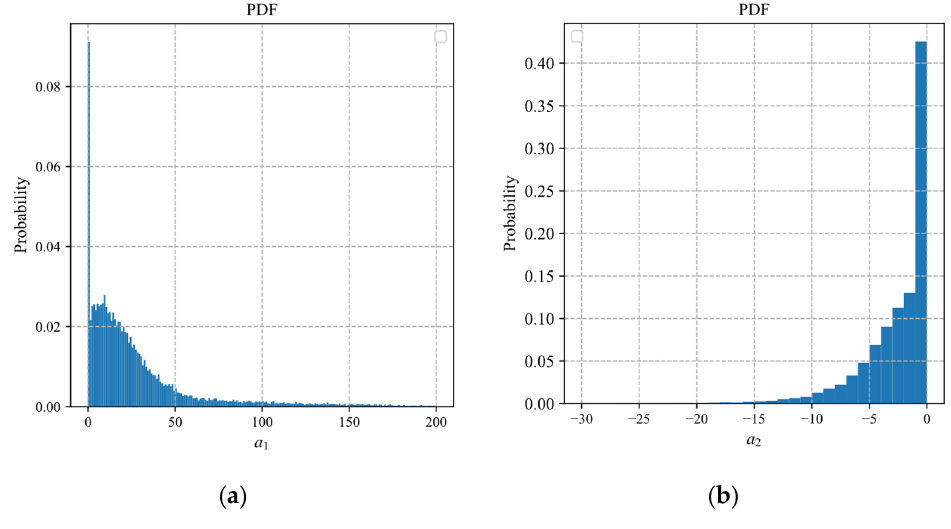
Figure 6. Probabilistic histograms of parameters: ( a ) a 1 ; ( b ) a 2 . To analyze the influence of a 2 on the exponential model, we construct the vector function G 1 ( a 2 ) = [ 2 0.1 × a 2 , 2 0.2 × a 2 , . . . , 2 0.8 × a 2 ] with respect to a 2 , where 0.1, 0.2, . . . , and 0.8 represent the most commonly used sampling rates. The integer values of the fitted interval of a 2 in Figure 6b are substituted into G 1 ( a 2 ) . The Pearson correlation coefficients (PCC) between two different vectors of G 1 ( a 2 ) are shown in Table 2. It is observed that the vectors of G 1 ( a 2 ) have high correlation with each other. When the value difference of a 2 is 1, the PCCs between two different vectors of G 1 ( a 2 ) are greater than 0.998. For example, for the values − 3 and − 4, with a value difference of 1, the PCC is 0.998. Therefore, we